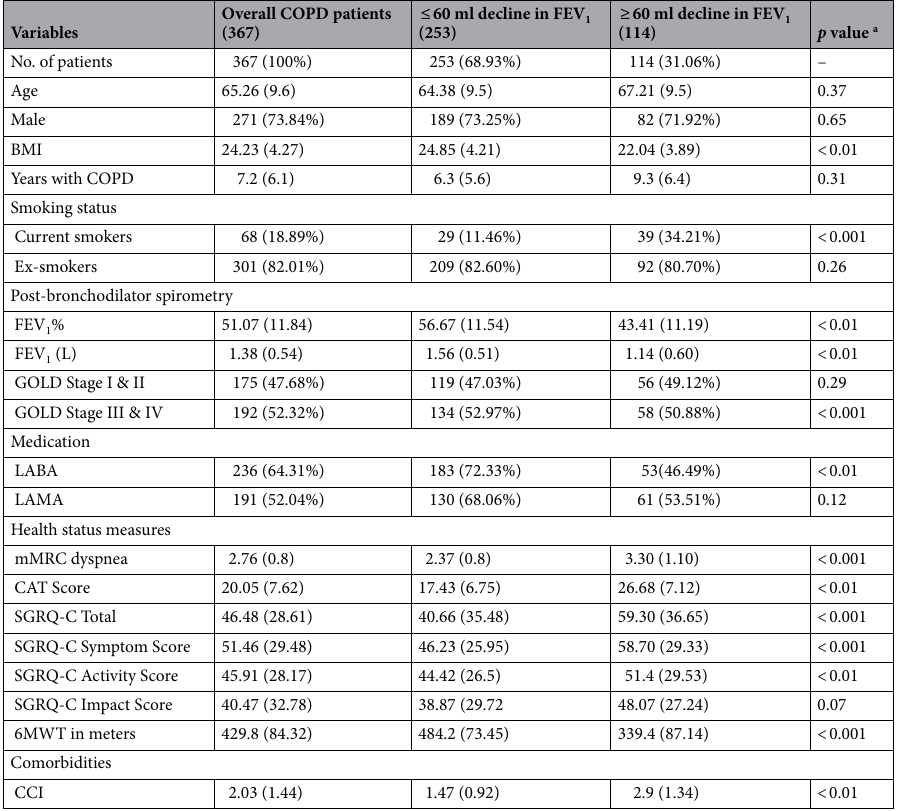
Table 1. Baseline demographic and clinical data of COPD patients included in the study. Data are presented as n (%) and mean (SD) unless otherwise stated. BMI, body mass index; COPD, Chronic Obstructive Pulmonary Disease; CAT, COPD assessment test; CCI, Charlson comorbidity Index; FEV 1 , forced expiratory volume in 1 second; FVC, forced vital capacity; FEV 1 %, percentage predicted FEV1; GOLD, global initiative for Chronic Obstructive Lung Disease; GOLD Stage I (FEV1 ≥ 80% predicted); GOLD stage II (50% ≤ FEV1 < 80% predicted); GOLD Stage III (30% ≤ FEV1 < 50% predicted); GOLD Stage IV (FEV1 < 30% predicted); LABA, long-acting beta agonist; LAMA, long acting muscarinic antagonist; 6MWT, six minute walking distance travelled; mMRC, modified medical research council dyspnoea scale, SGRQ-C, St George’s Respiratory COPD specific Questionnaire. a The difference was assessed among groups stratified according to decline in FEV 1 .